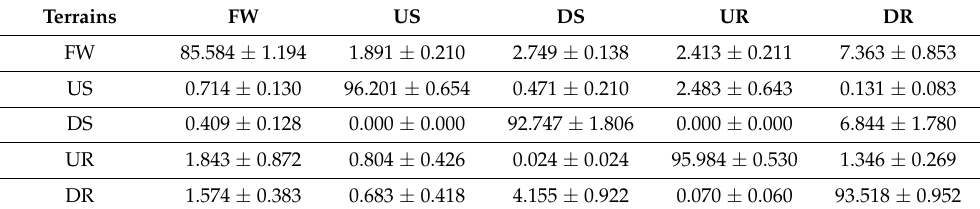
Table 4. Confusion matrix (MEAN ± SEM) for experimental results of HSVM (%).